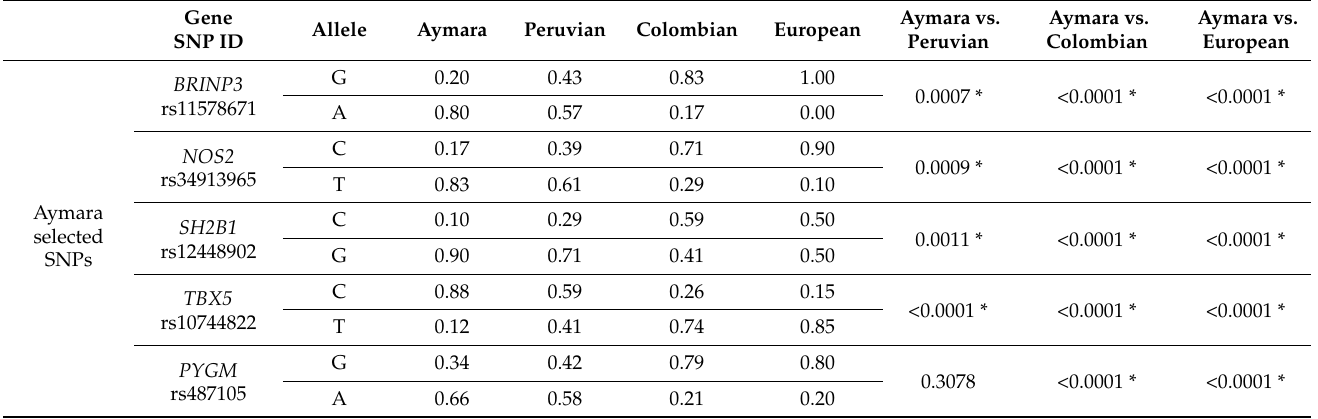
Table 1. Allele frequencies in Aymara, Peruvian, Colombian, and European